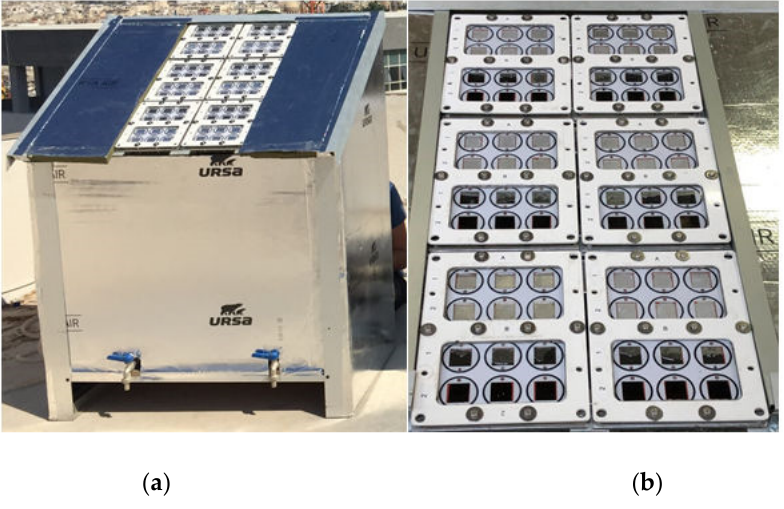
Figure 1. ( a ) Aging unit and ( b ) tile arrangement.